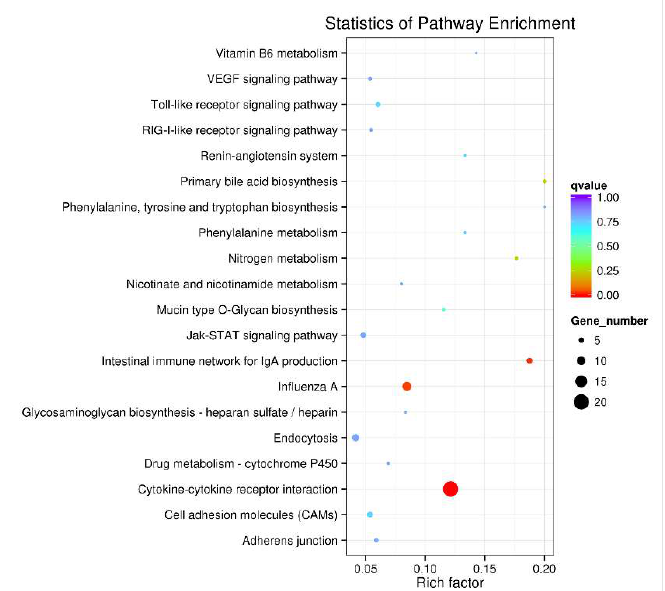
Figure 5. The top 20 Kyoto Encyclopedia of Genes and Genomes (KEGG) pathways of SDEGs of D_S group and B_S group. The color of the dot represents the q value, and the size of the dot represents the number of SDEGs enriched in the reference pathway.